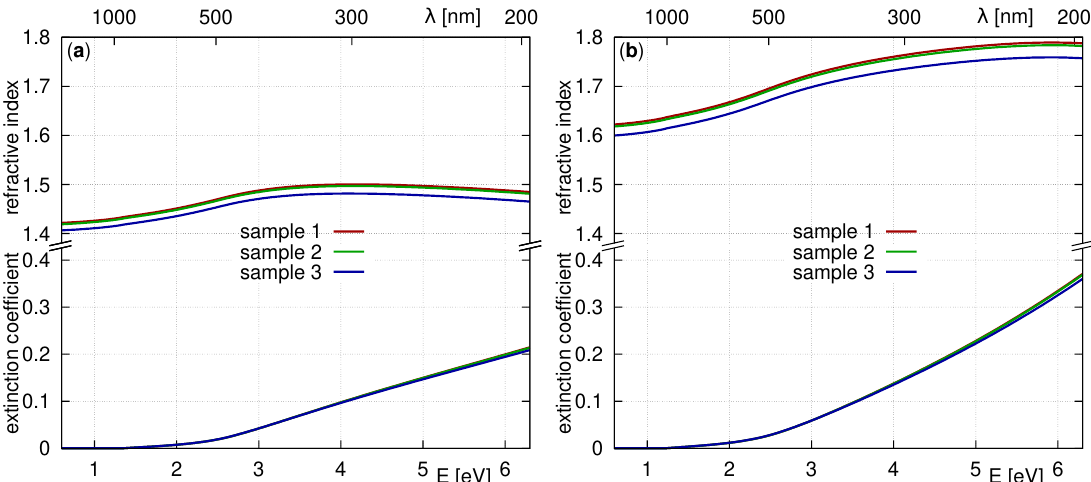
Figure 2. Spectral dependencies of the optical constants of the inhomogeneous films at the upper boundary for: ordinary wave ( a ); and extraordinary wave ( b ).